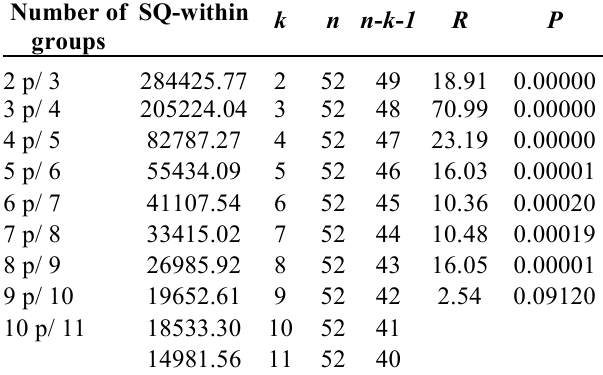
Table 2 . Results used to calculate the R statistic, which evalu- ates if the increase from k to k + 1 groups is significant. SQ - Within = Total sum of squares within; n = number of species (objects); n - k - 1 = degrees of freedom; P = probability of type I